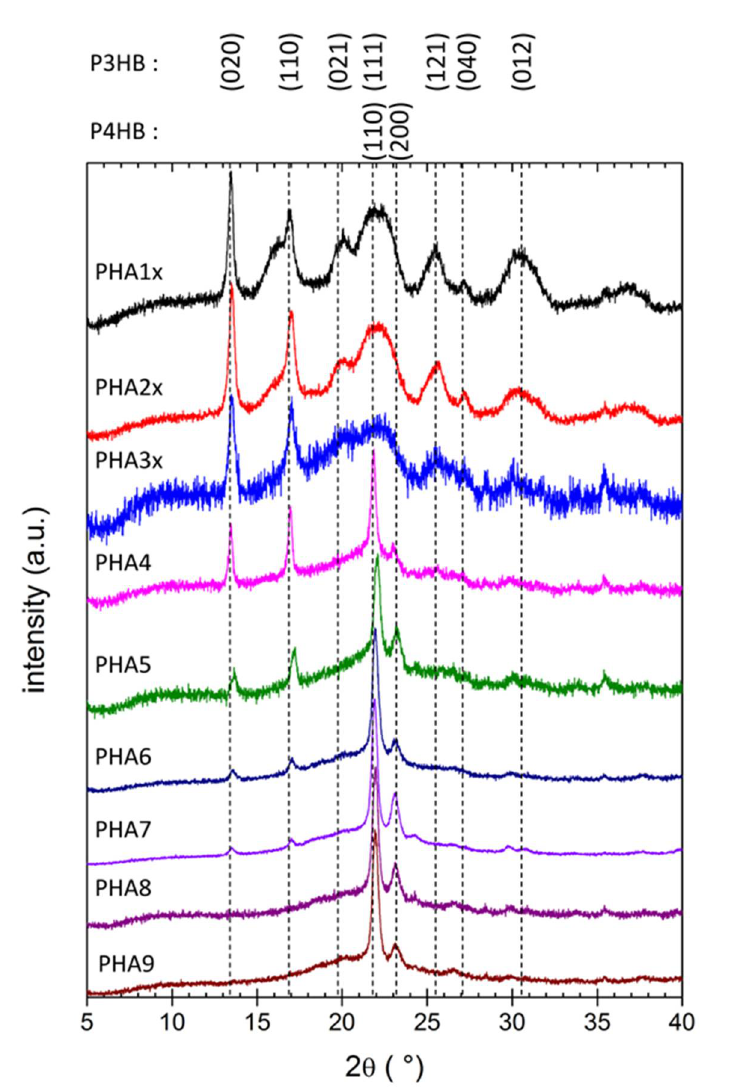
Figure 2. X-ray diffraction patterns of copolymer PHA films. Diffractograms were normalized for clarity. Reflections are assigned to P(3HB) and P(4HB) lattices, respectively, according to Gao et al. [25] and Keridou et al. [27].